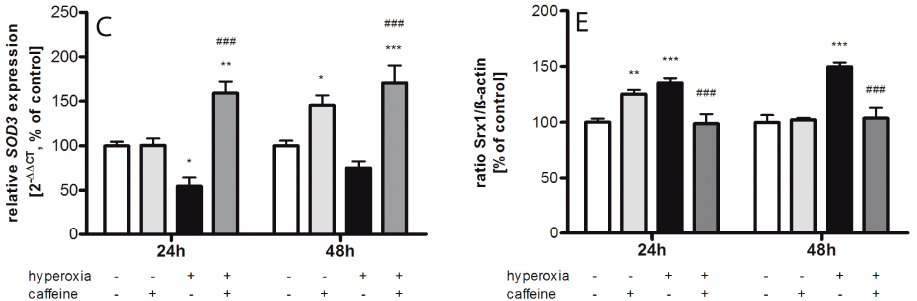
Figure 2. Caffeine modulates antioxidative enzymes. ( Box ) The high production of ROS under oxidative stress requires the existence of a set of ROS scavenger mechanisms. These are firstly, the group of superoxide dismutase (SOD), which are not only able to scavenge ROS but also repair cell damage and possibly serve as redox sensors, and secondly, the thiol-based antioxidants peroxiredoxin (Prx) as well as sulfiredoxin (Srx), which are major internal housekeeping antioxidant molecules that act as redox switches to modulate homeostasis. SOD isoform mRNA expression was analyzed in brain homogenates. Quantification of mRNA expression by quantitative real-time PCR of: ( A ) SOD1 ; ( B ) SOD2 ; and ( C ) SOD3 ; and protein expression measured by Western blot of: ( D ) Prx1; and ( E ) Srx1. Groups are shown as normoxia ( white bars ), hyperoxia ( black bars ), with and without caffeine (dark grey and light grey bars, respectively) as mean ± SEM, n = 4–5 per group per time point. The 100% value is: ( A ) 1.031 and 1.006 C T ; ( B ) 1.002 and 1.025 C T ; ( C ) 1.005 and 1.007 C T ; ( D ) 0.87 and 0.61 ratio intensity/mm 2 ; and ( E ) 0.39 and 0.67 ratio intensity/mm 2 , for 24 h and 48 h groups, respectively. Data were analyzed by two-way ANOVA with Bonferroni post hoc test, with * p < 0.05, ** p < 0.01, and *** p < 0.001 versus control (atmospheric air), and # p < 0.05, ## p < 0.01, and ### p < 0.001 versus hyperoxia (80% oxygen without caffeine).